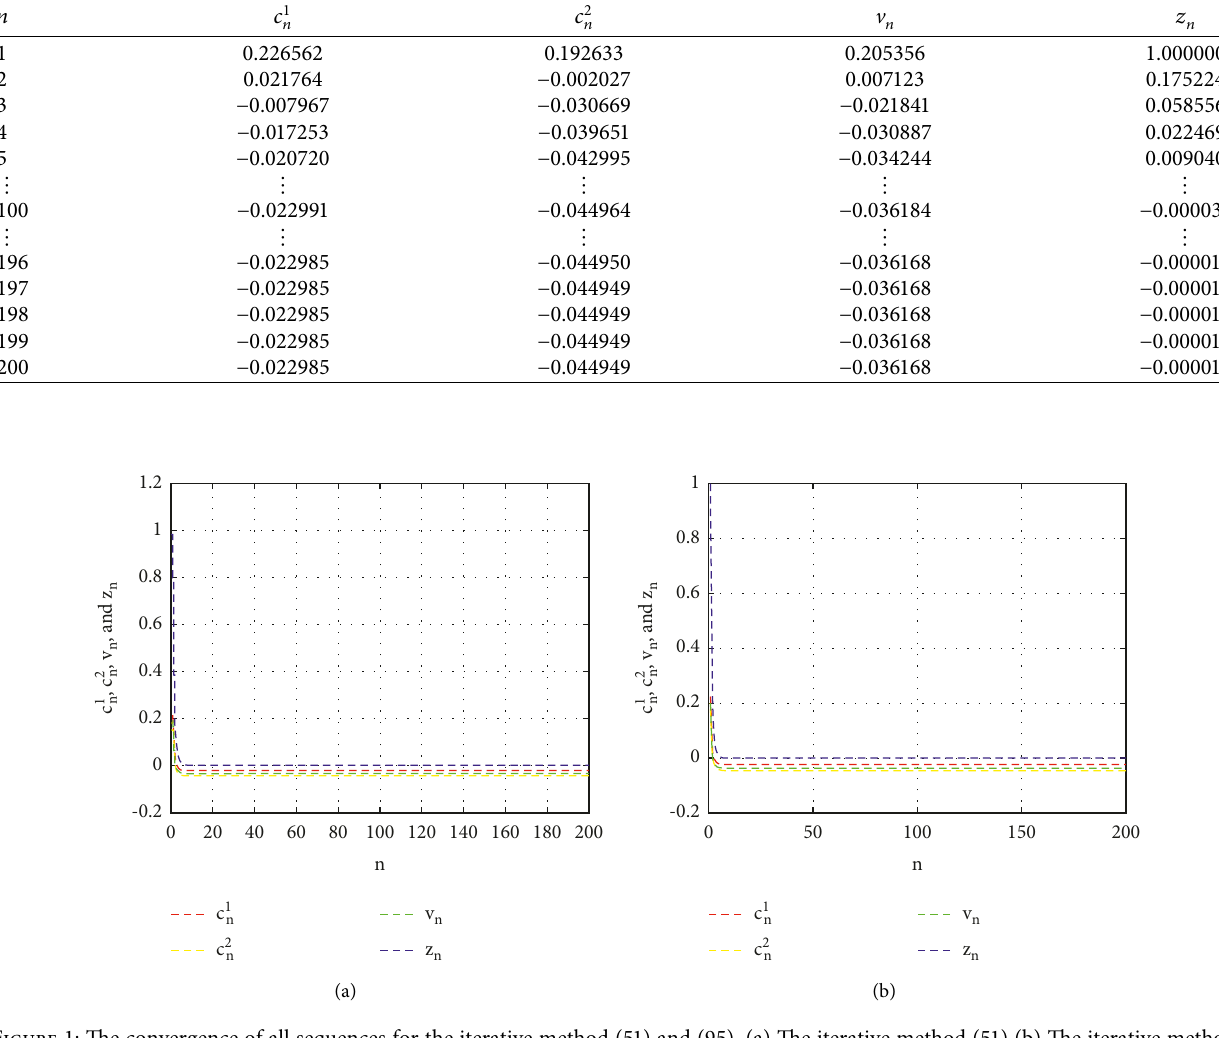
Table 1: The values of all sequences for the iterative method (51).